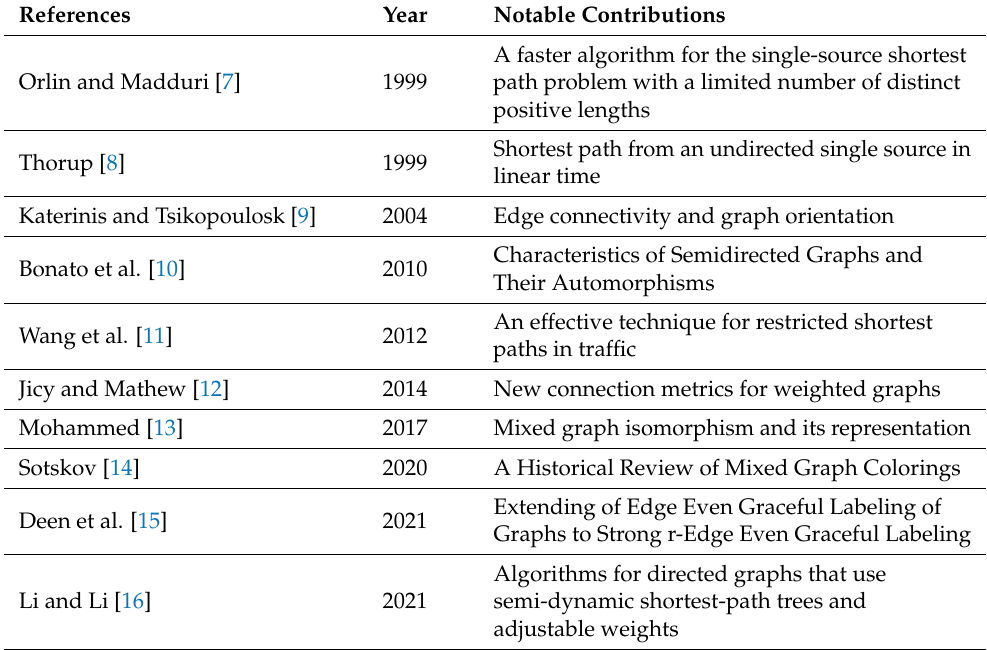
Table 1. Notable contributions implemented by different researchers to the analyses of different graph-related problems.